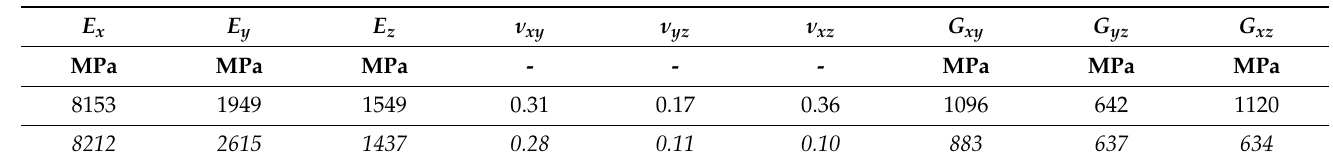
Table 3. Material parameters determined from simulation-based fitting, rounded. Experimental start values from Table 1 are repeated in